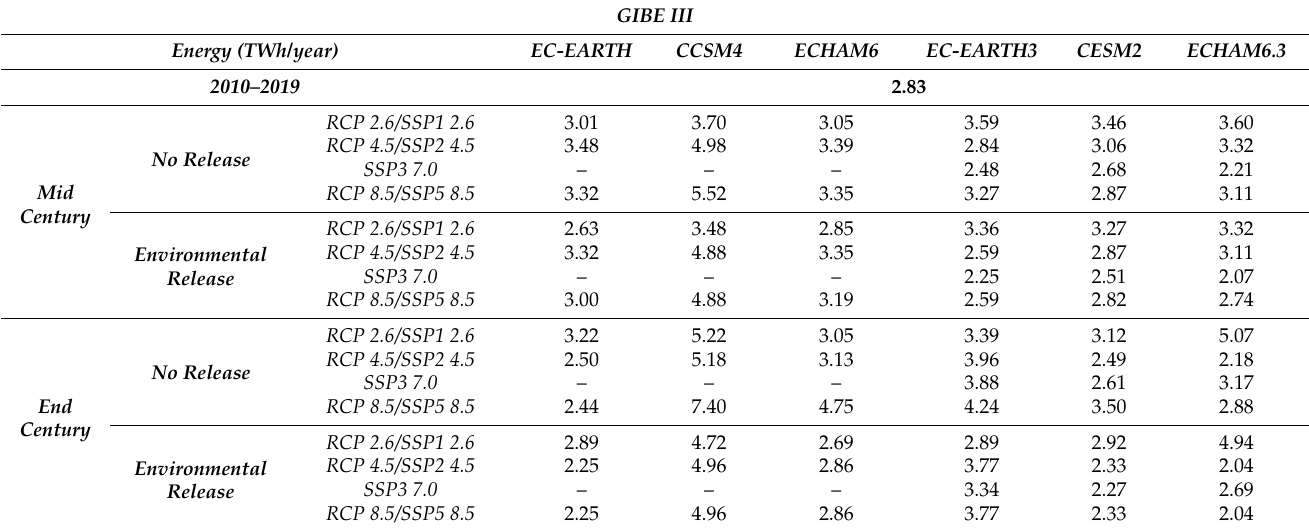
Table 8. GIBE III. Average projected yearly hydropower